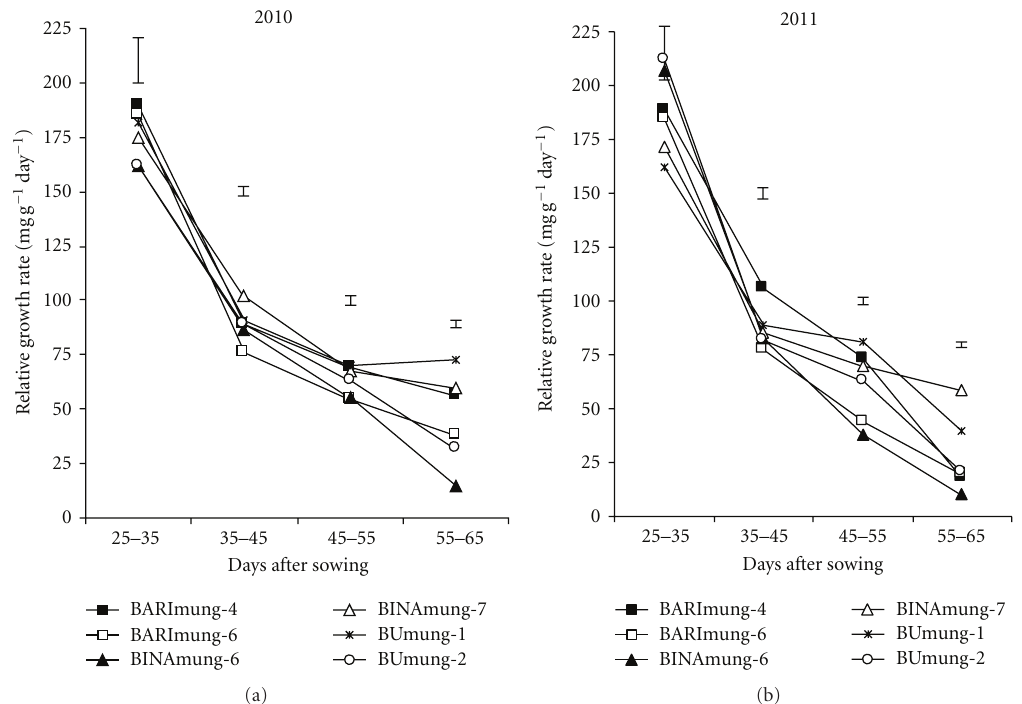
Figure 4: Pattern of relative growth rate in six mungbean varieties during their growth period. Vertical bars represent LSD (0.05).